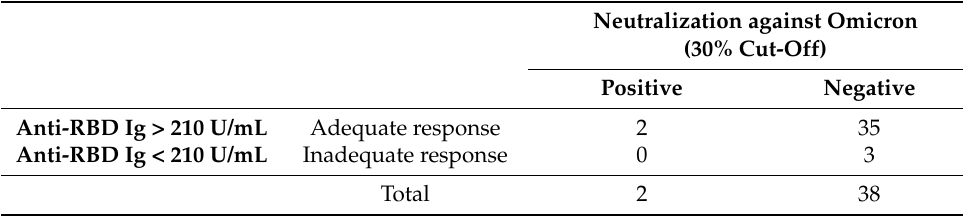
Table 2. Surrogate neutralization for SARS-CoV-2 Omicron (B.1.1.529) BA. 2 in solid cancer